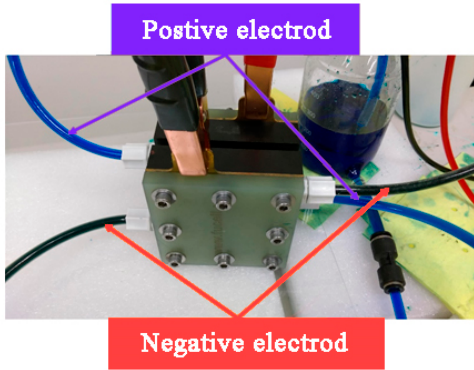
Figure 11. Color states of positive and negative vanadium electrolytes after precharge.